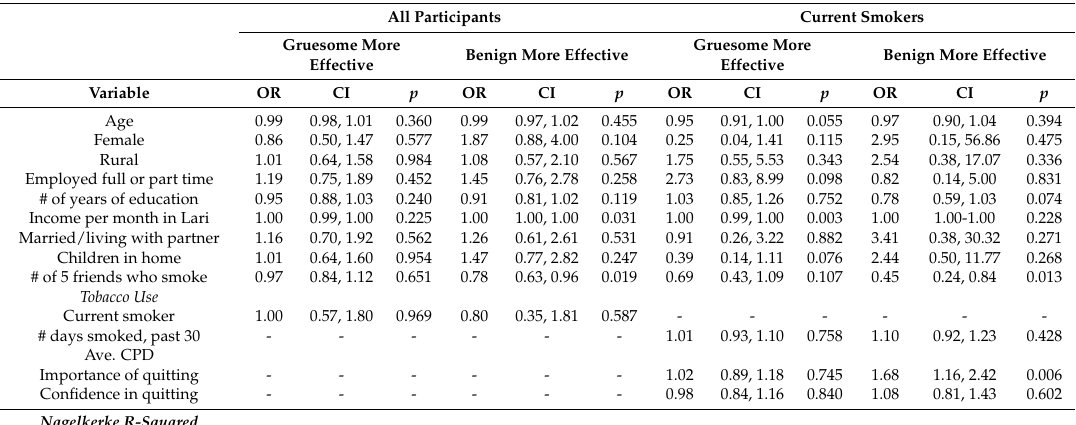
Table 3. Multinomial logistic regressions comparing those who rated gruesome or benign as more effective relative to no difference (referent group), Set